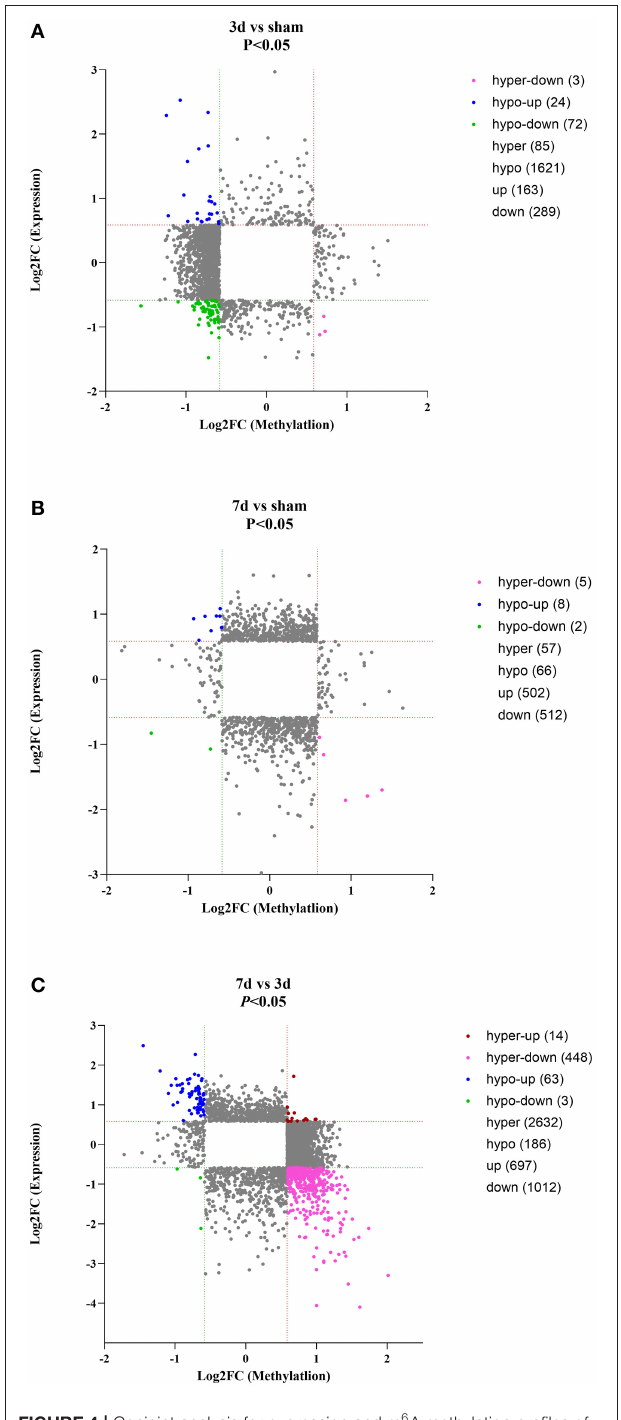
FIGURE 4 | Conjoint analysis for expression and m 6 A methylation profiles of circRNAs around the infarct cortex in 3d vs. sham (A) , 7d vs. sham (B) , and 7d vs. 3d (C)